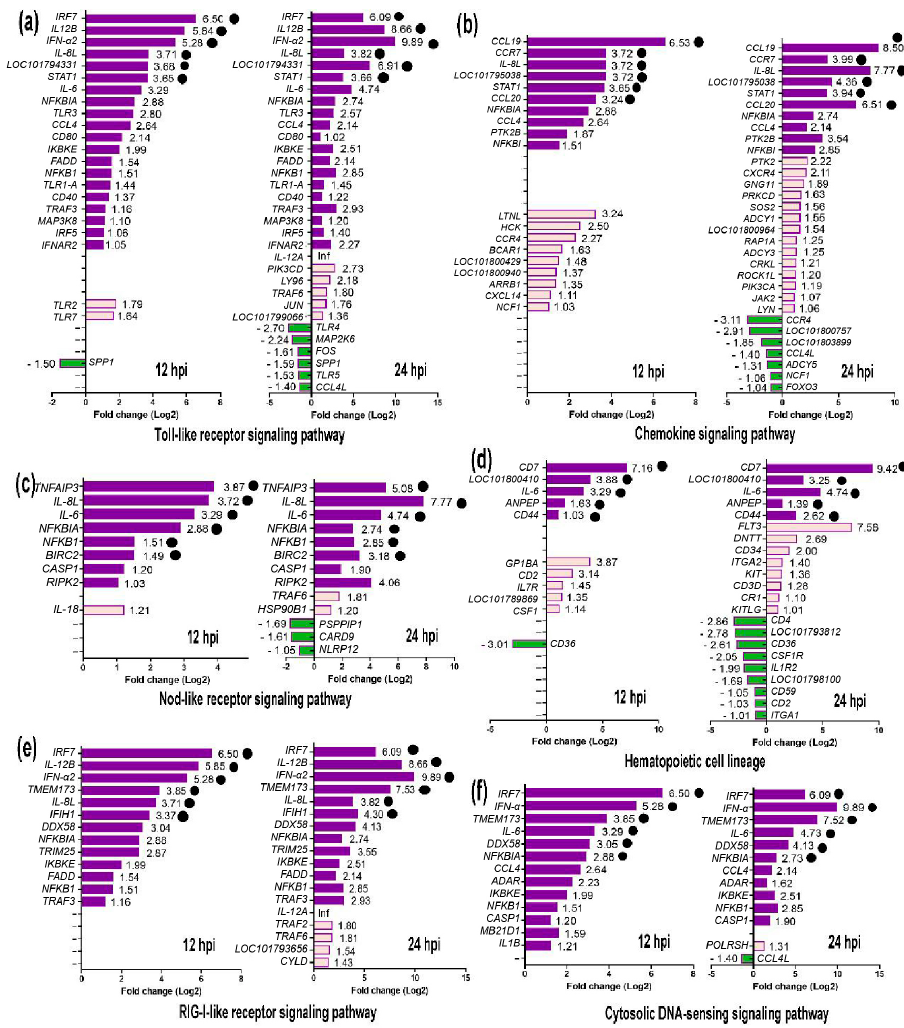
Figure 7. Differentially expressed genes (DEGs) in six common immune system ‐ related signaling pathways at 12 and 24 h post ‐ infection (hpi). ( a ) DEGs in Toll ‐ like receptor signaling pathway at 12 and 24 hpi. ( b ) DEGs in Chemokine signaling pathway at 12 and 24 hpi. ( c ) DEGs in Nod ‐ like receptor signaling pathway at 12 and 24 hpi. ( d ) DEGs in Hematopoietic cell lineage at 12 and 24 hpi. ( e ) DEGs in RIG ‐ I ‐ like receptor signaling pathway at 12 and 24 hpi. ( f ) DEGs in Cytosolic DNA ‐ sensing signaling pathway at 12 and 24 hpi. The six DEGs with the largest fold changes in expression in each pathway are marked by black dots.